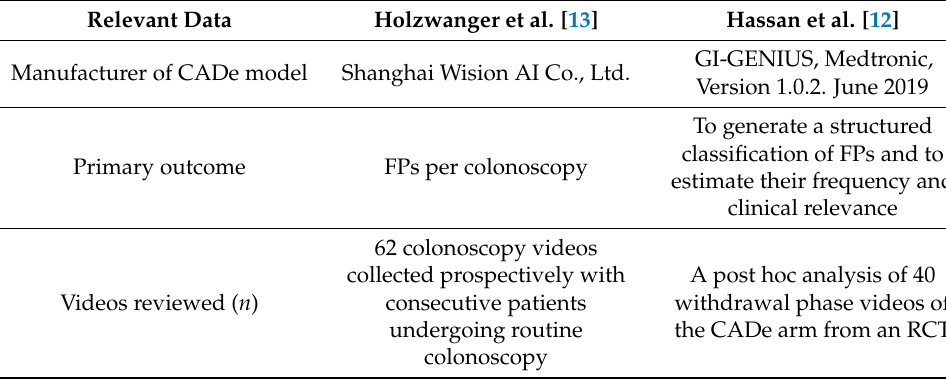
Table 4. Video analysis studies using FPs as the primary